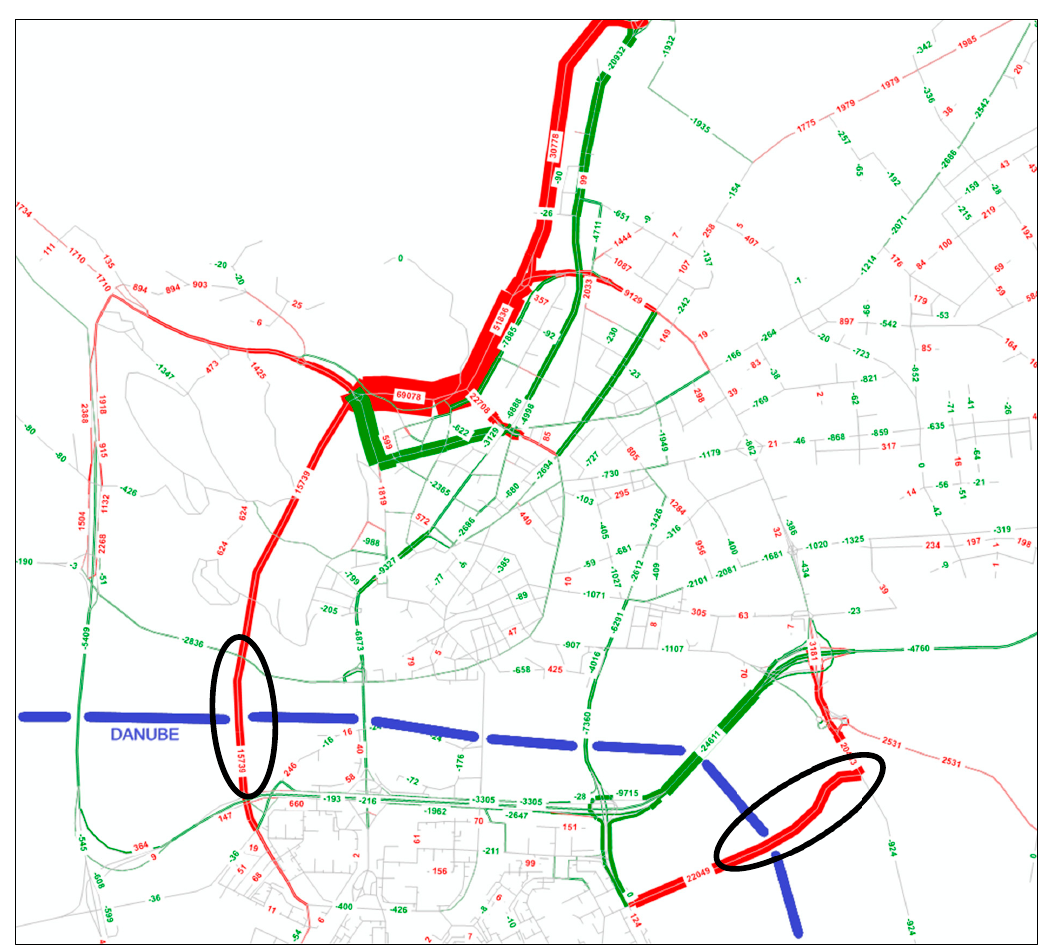
Figure 12. Example of a “split up” traffic scenario with new city bridges (in black circles) in Bratislava.